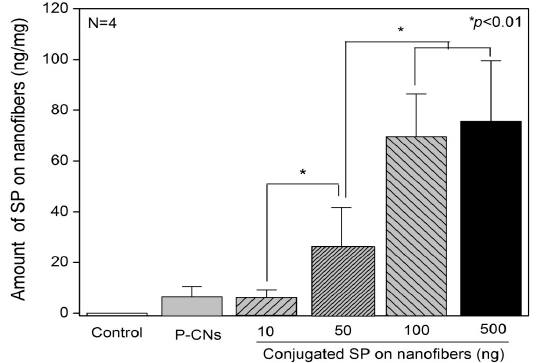
Figure 3. The amount of SP on nanofibers was analyzed using ELISA. SP was passively-adsorbed onto nanofibers (P-CNs) at a single concentration (100 ng) or actively immobilized on nanofibers (S-CNs) at different concentrations (10, 50, 100 and 500